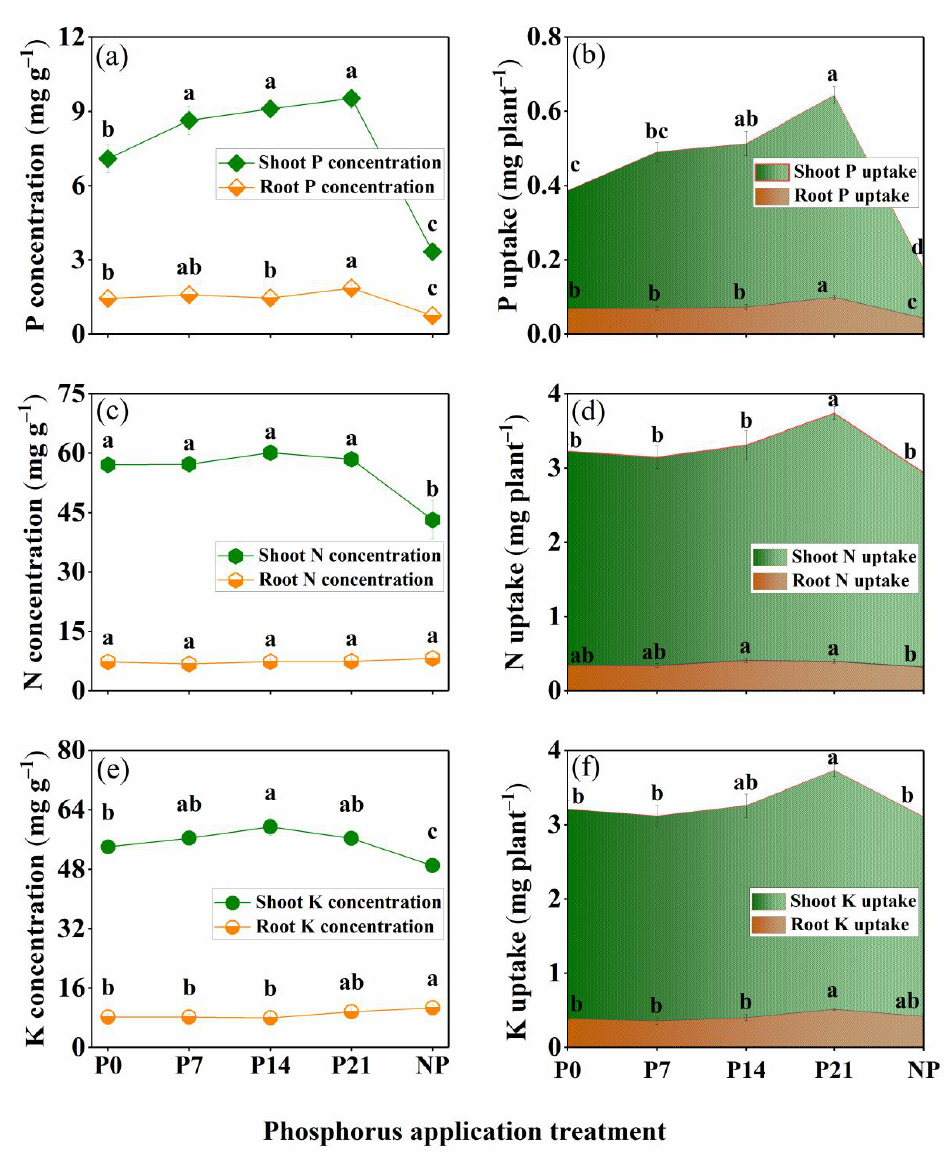
Figure 4. P, N, and K concentration and uptake as a function of P application time: ( a ) P concentration; ( b ) P uptake; ( c ) N concentration; ( d ) N uptake; ( e ) K concentration; ( f ) K uptake. P0 means P application at planting; P7 means P application at 7 d after planting; P14 means P application at 14 d after planting; P21 means P application at 21 d after planting; and NP means no P application. Different lowercase letters mean significant differences in P, N, and K concentrations and uptake among different treatments at p < 0.05, n =